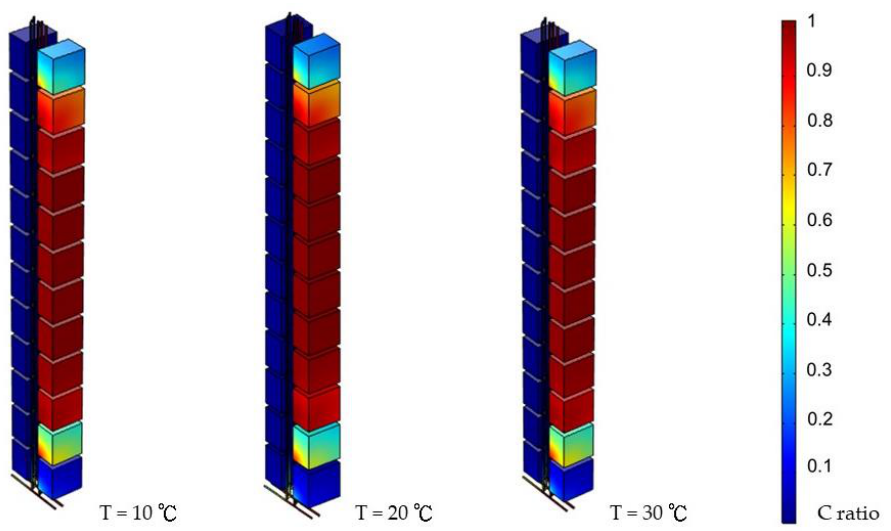
Figure 10. Simulation results for various T (day 3, 0.05 Pa).